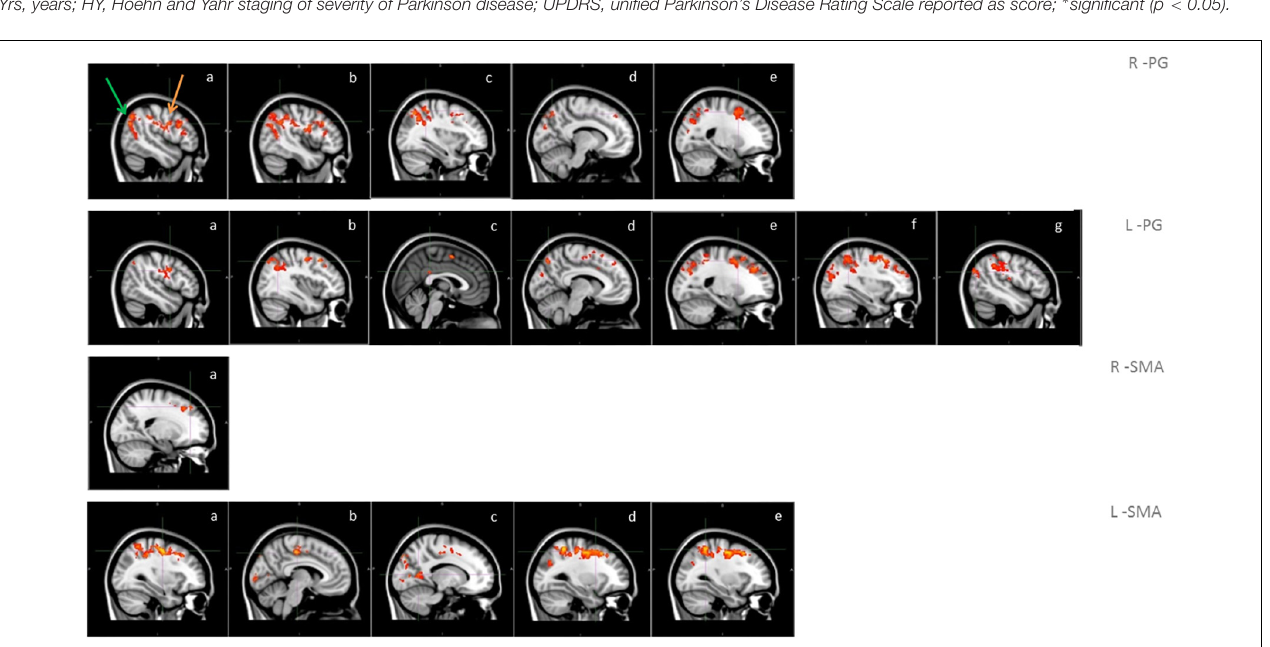
FIGURE 1 | Functional connectivity in the group analysis of ON state vs. OFF state; images show sagittal views of the main areas with significant clusters of voxels, superimposed on the MNI template; box R-PG: connectivity with seed in right precentral gyrus (a: occipital cortex -green arrow-, motor areas -orange arrow-, b: angular gyrus, c: superior parietal lobe, d: precuneus, e: superior frontal gyrus); box L-PG: connectivity with seed in left precentral gyrus (a: motor areas, b: superior frontal gyrus, c: superior parietal lobe, d: angular gyrus, e: precuneus, f: cingulum, g: occipital cortex); box R-SMA: connectivity with seed in right SMA (a: